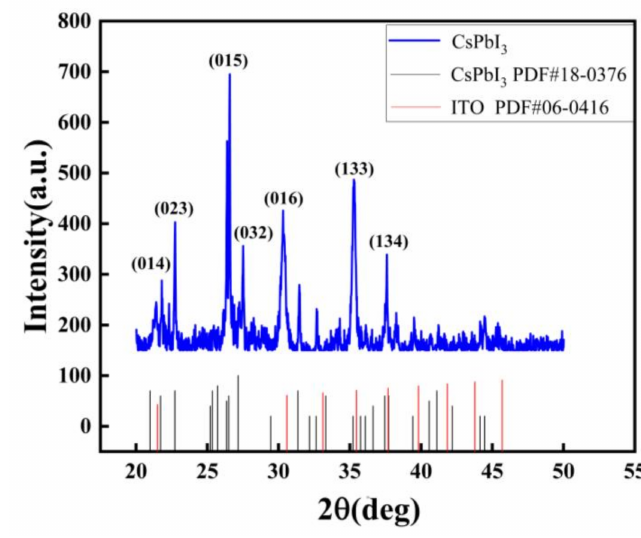
Figure 1. XRD patterns of the Au/CsPbI 3 /ITO artificial synapse.